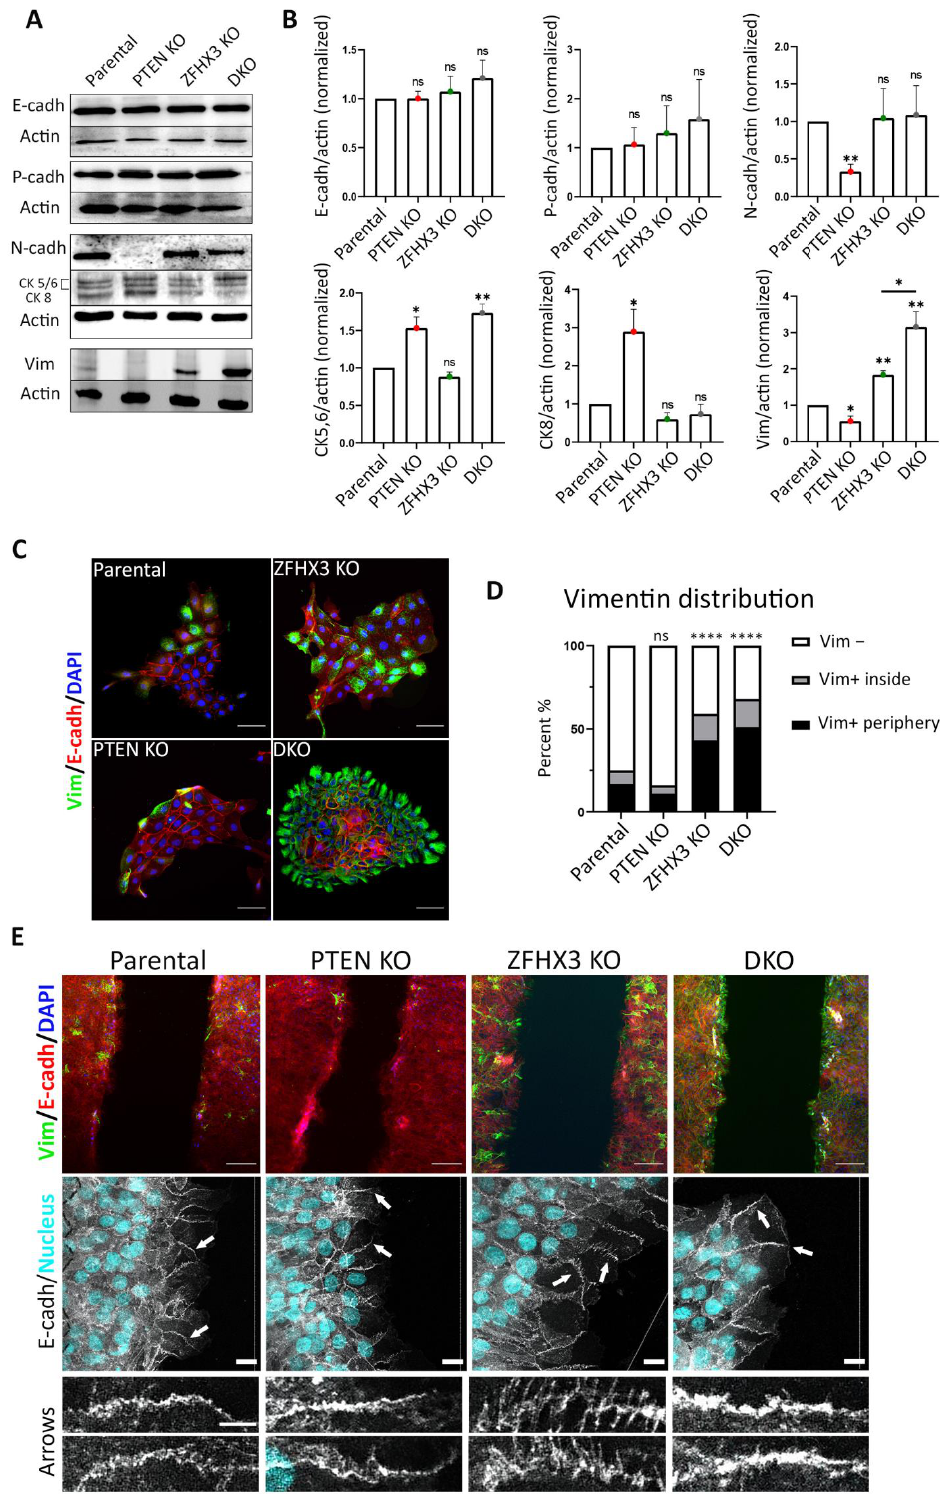
Figure 5. EMT features in gene-edited MCF10A cell lines. ( A ) Alteration of expression of E-, N- and P-cadherins; vimentin; and cytokeratins (5, 6, 8), and actin was used for normalization of protein loading (Western blots). ( B ) Quantification of Western blots by densitometry. Mean ± SEM from 3 independent experiments. ( C ) Immunofluorescence staining of islets for vimentin (green), E-cadherin (red) and nuclei (blue) . Scale bars: 50 μm for islet images. ( D ) Quantification of vi- mentin-positive and -negative cells within islets or at their periphery. ( E ) Top images: immuno- fluorescence staining of wound edges for vimentin (green), E-cadherin (red) and nuclei (blue). Scale bars: 100 μm. Middle images: confocal microscopy of E-cadherin immunofluorescence in wound healing experiments. Nuclei are in cyan. Note the radial AJ in ZFHX3 KO. Arrows indicate the magnified junctions displayed below. Scale bars 18 μm for main immunofluorescence images and 5 μm for magnified junctions. Three independent experiments. Sample size (the number of calculated Vim + cells) for each experiment is: parental 193, 236, 438; PTEN KO 190, 235, 481; ZFHX3